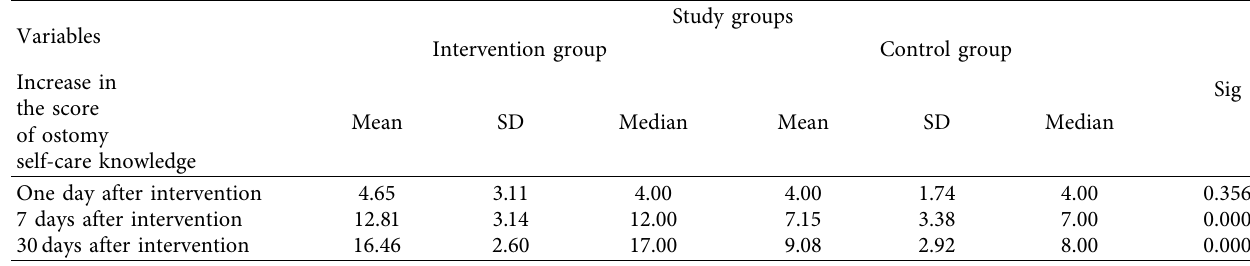
Table 1: Te comparison of the mean score of ostomy self-care knowledge between the intervention and control groups after the completion of the programme.